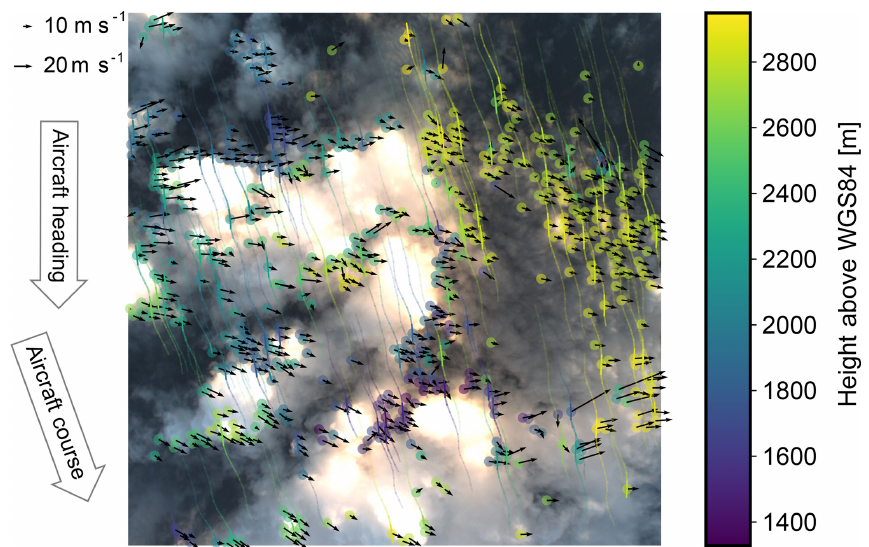
Figure 2. Image point tracking. Every line in this image represents a cloud feature which has been tracked along up to 30 images. The images used were taken on NAWDEX flight RF07 (6 October 2016, 09:32:15UTC; location indicated in Fig. 7) in an interval of 1s. Transparency of the tracks indicates time difference to the image. Color indicates retrieved height above WGS84, revealing that the larger clouds on the left belong to a lower layer than the thin clouds on the right. The arrows indicate estimated cloud movement. Due to the wind speed at the aircraft location, its course differs significantly from the heading and the tracks are tilted accordingly. The number of points shown has been reduced to include at maximum one point per 20px radius in the image. Tracks are only shown for every fifth